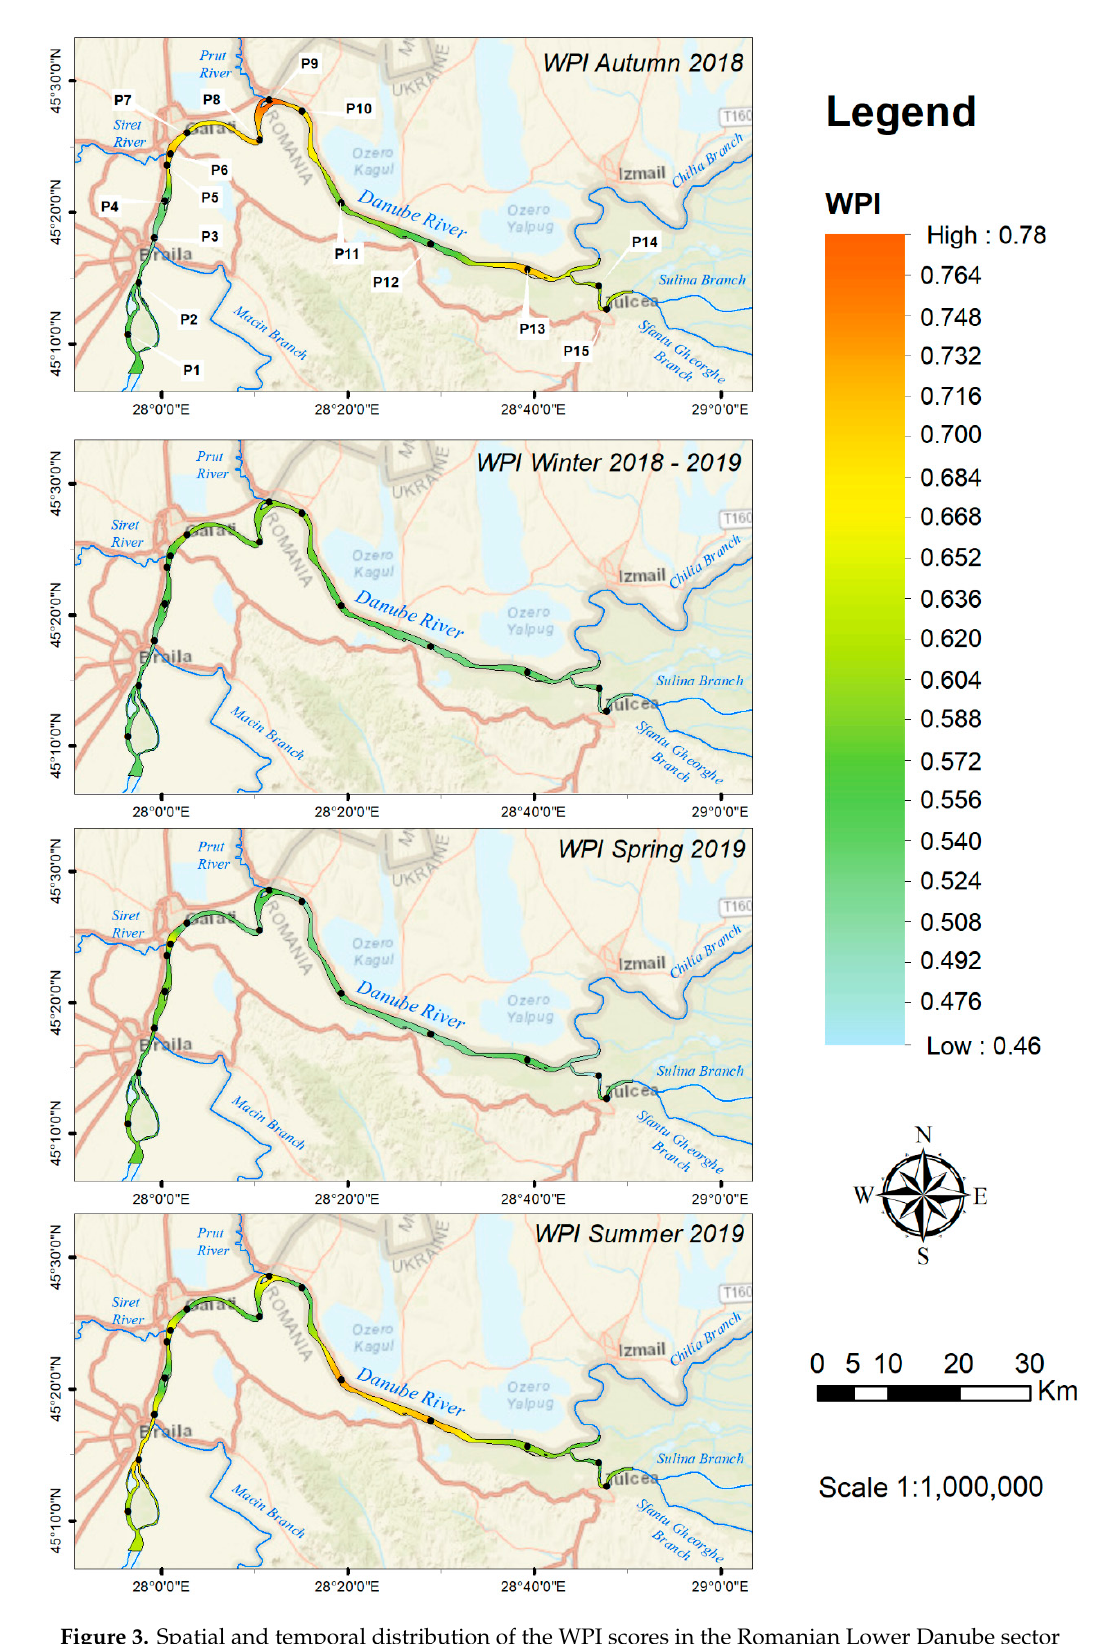
Figure 3. Spatial and temporal distribution of the WPI scores in the Romanian Lower Danube sector recorded during the period autumn 2018–summer 2019.